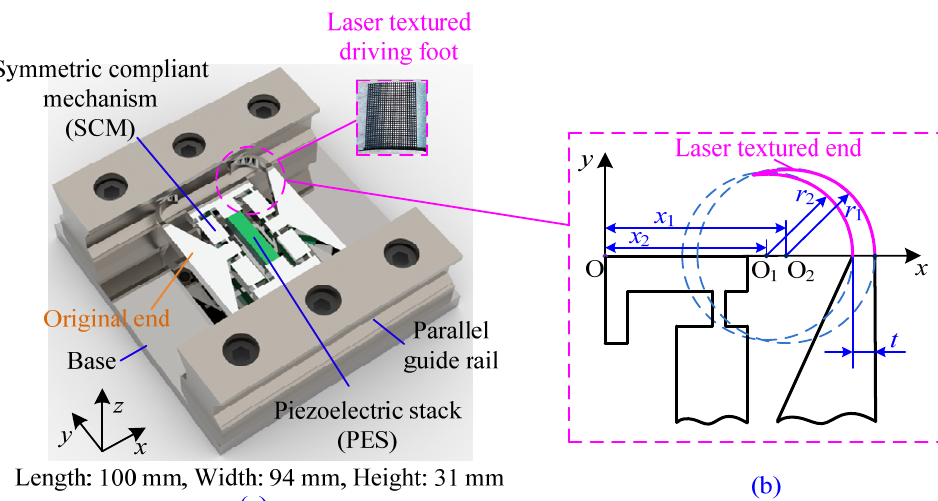
Figure 2. ( a ) Structure of the developed actuator with laser-textured driving feet and ( b ) detailed structure of a quarter of the arc-shaped driving foot.